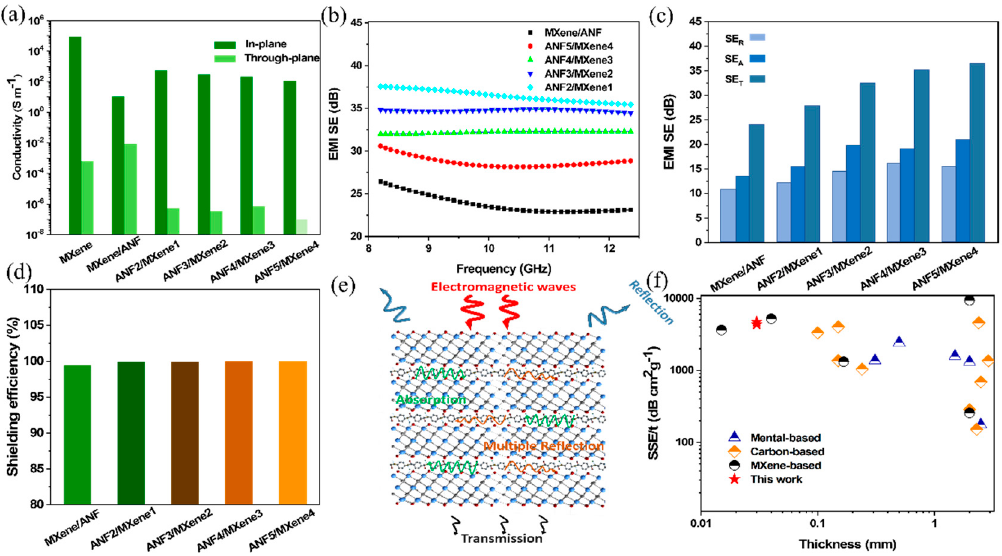
Figure 4. ( a ) Electrical conductivities of MXene film, homogeneous MXene/ANF film and multilayer-structure films; ( b ) EMI shielding performances of homogeneous MXene/ANF film and multilayer-structure films; ( c ) average EMI microwave reflection (SE R ), microwave absorption (SE A ) and total shielding effectiveness (SE T ) of multilayer-structure films; ( d ) overall shielding efficiency of homogeneous MXene/ANF film and multilayer-structure films of ANF2/MXene1, ANF3/MXene2, ANF4/MXene3 and ANF5/MXene4; ( e ) schematic illustration of the electromagnetic shielding mechanism of multilayer- structure films; ( f ) comparison of SSE/t as a function of thickness with previous reports. The detailed information is listed in Table